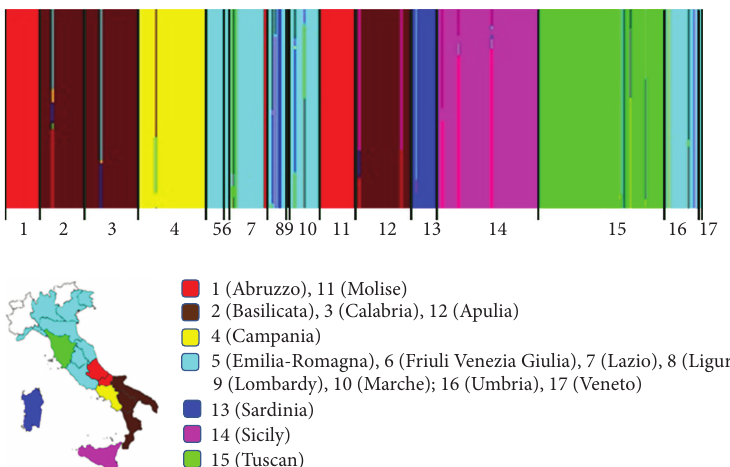
Figure 2: BAPS analysis on the 439 Italian olive varieties. In the graph, each colour represents a population group based on allele frequency. Vertical bars represent each olive variety analyzed in this study and bars are divided into several colours when there is evidence of admixture. Table 3: Genetic diversity parameters at SSR loci estimated in BAPS groups identified in this study. For each cluster, the observed heterozygosity ( 𝐻𝑜 ), the expected heterozygosity ( 𝐻𝑒 ), and the fixation index ( 𝐹 ) are reported. BAPS clusters 𝐻𝑜 𝐻𝑒 𝐹 Cluster